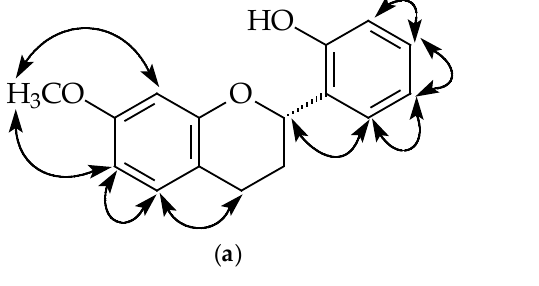
Figure 4. Key NOESY contacts ( a ) and HMBC connectivities ( b ) of compound 3 . Compound 4 was isolated as a colorless oil. Its molecular formula, C 17 H 20 O 4 , was determined by HREIMS ([M] + , 288.1363). The 1 H-NMR spectrum (Table 1 and Figure S28) of 4 was similar to that of 2 , except the typical aromatic proton signals of the B-ring were absent. Instead, four aliphatic protons at δ 2.16, 2.49, 2.81, and two vinylic hydrogens [6.06 (d, J = 10.4 Hz, H-3’), 7.09 (dd, J = 10.4, 1.2 Hz, H-2’)] provided evidence of a cyclohexenone non-aromatic B-ring. Moreover, an additional carbonyl group at δ 198.2 (C-4’) and conjugated vinylic carbons at δ 129.5 (C-3’) and 148.7 (C-2’) in the 13